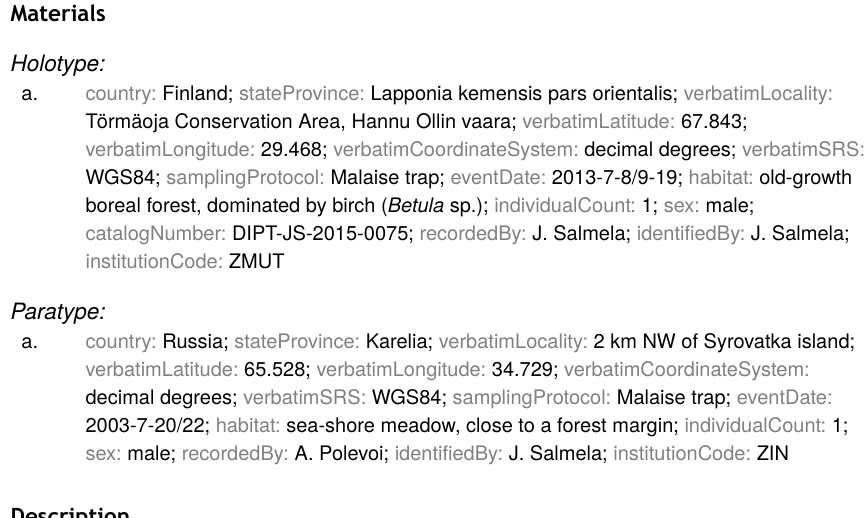
bare, other veins setose, veins light brown to dark brown. C exceeding tip of R5 25 % of the distance between R5 and M1. Sc2 situated between base of Rs and R4. Furcation point of median fork at the level of bRs. M1+M2 very short. Length ratio of M1+2:r-m = 0.53. Wing length 3.2